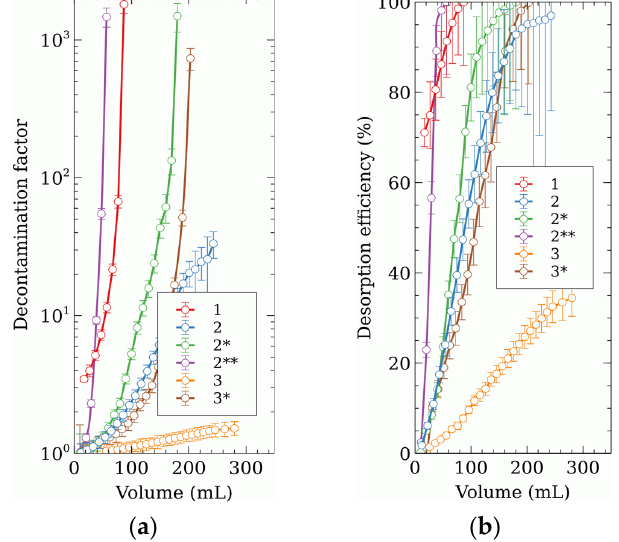
Figure 8. The effect of the concentration of H 2 SO 4 solution on the decontamination efficiency of the